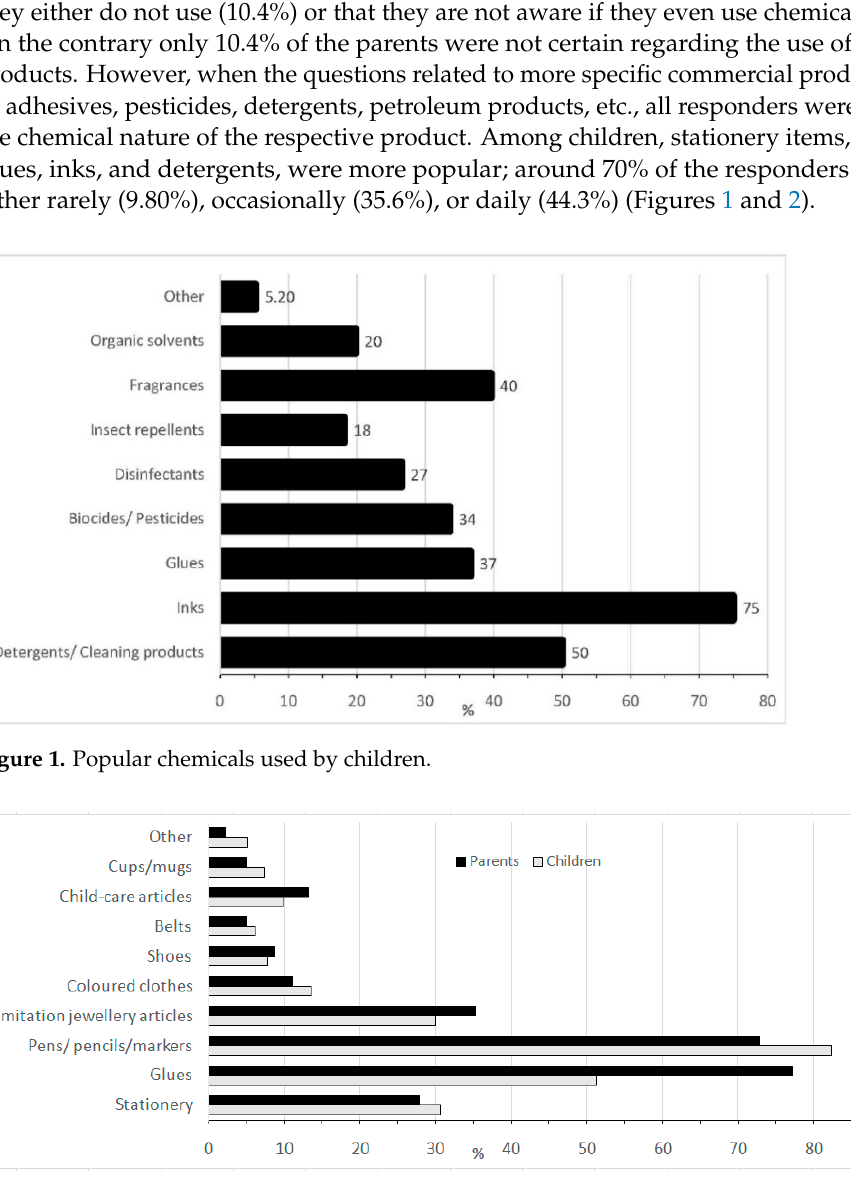
Figure 2. Exposure to chemicals via the use of articles as perceived by users (%).